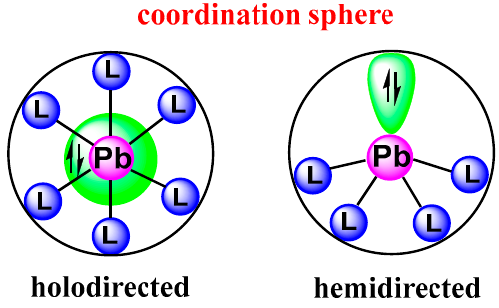
Chart 1. Simplified diagram for holodirected and hemidirected coordination spheres around